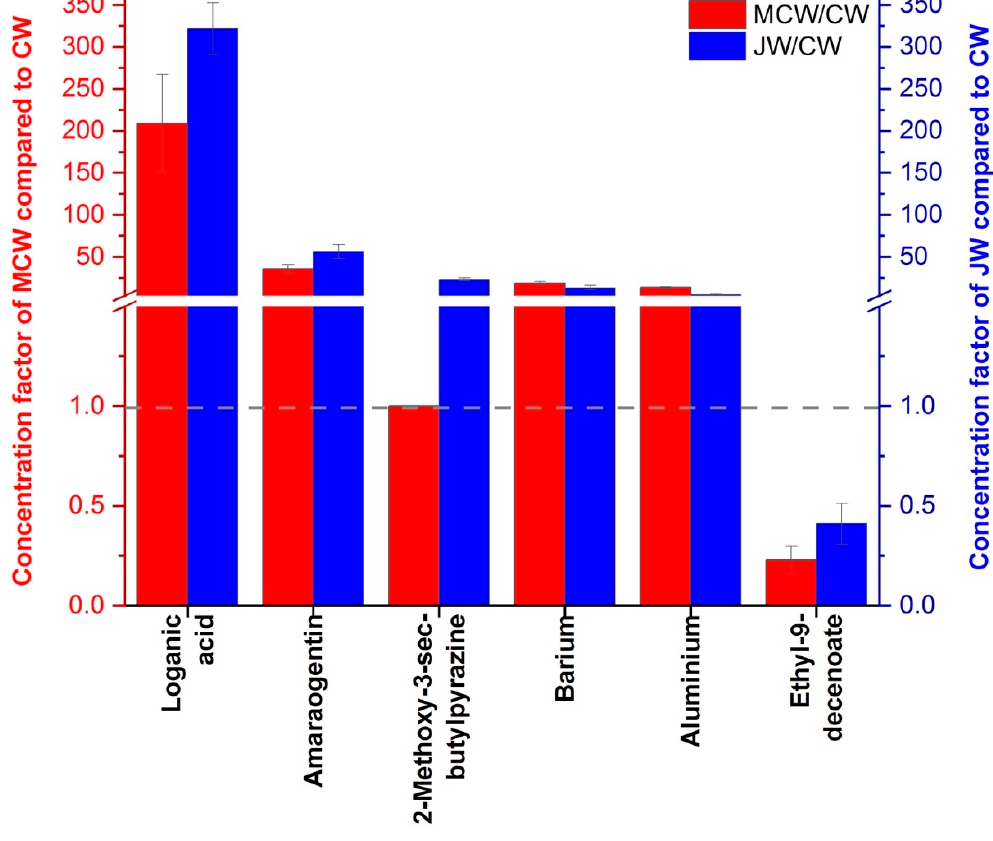
Figure 4. Concentration factor of chemical markers of gentian macerated wine that could explain sensory differences between macerated and unmacerated wine for MC and J gentian roots. The break on the y-axis was done from 1.5 to 3.9, minimum concentration factor value considered arbitrarily to affect sensory properties in macerated wine compared to CW. For loganic acid and amarogentin and 2-methoxy-3-sec-butylpyrazine, totally absent in CW, we consider for the calculation of concentration factor the concentration detection limit concentration or minimum area threshold values.